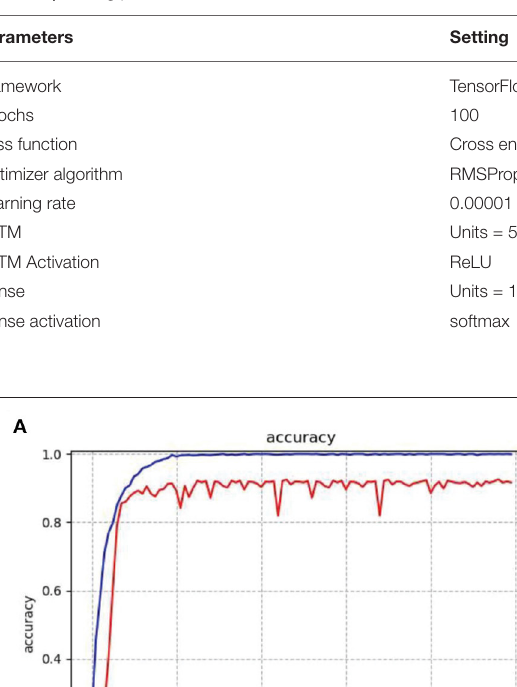
TABLE 1 | Traning parameters.